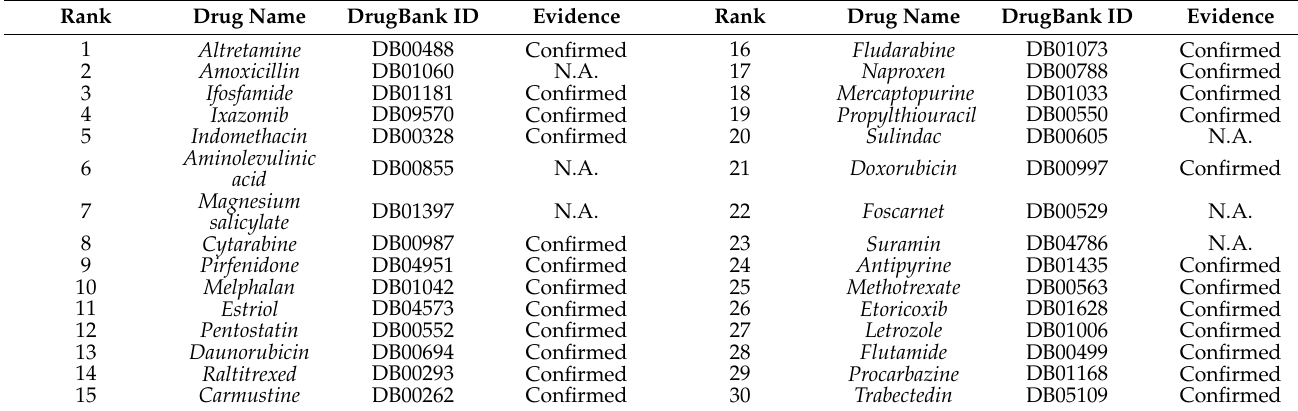
Table 5. The top 30 interactions of Cyclophosphamide .